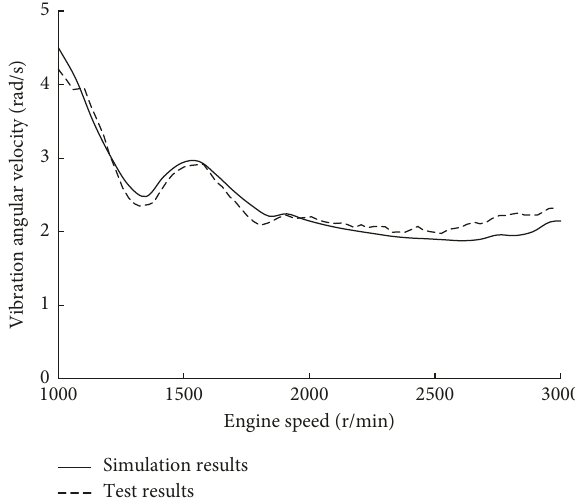
Figure 19: Comparison of drivetrain torsional vibration simulation and test